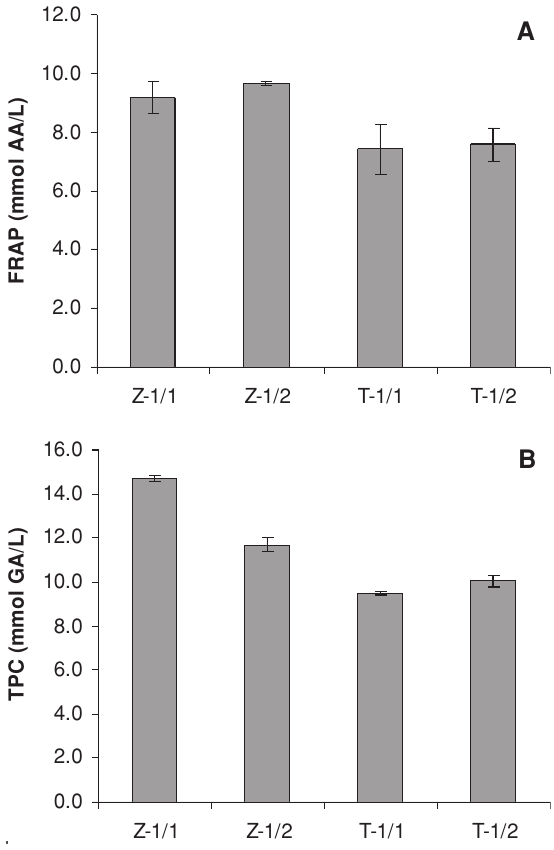
Figure 3. Antioxidant capacity (A) and total phenolics content (B) in conserved fruits of blackthorn selections, collected in 2009, Lövôpetri,